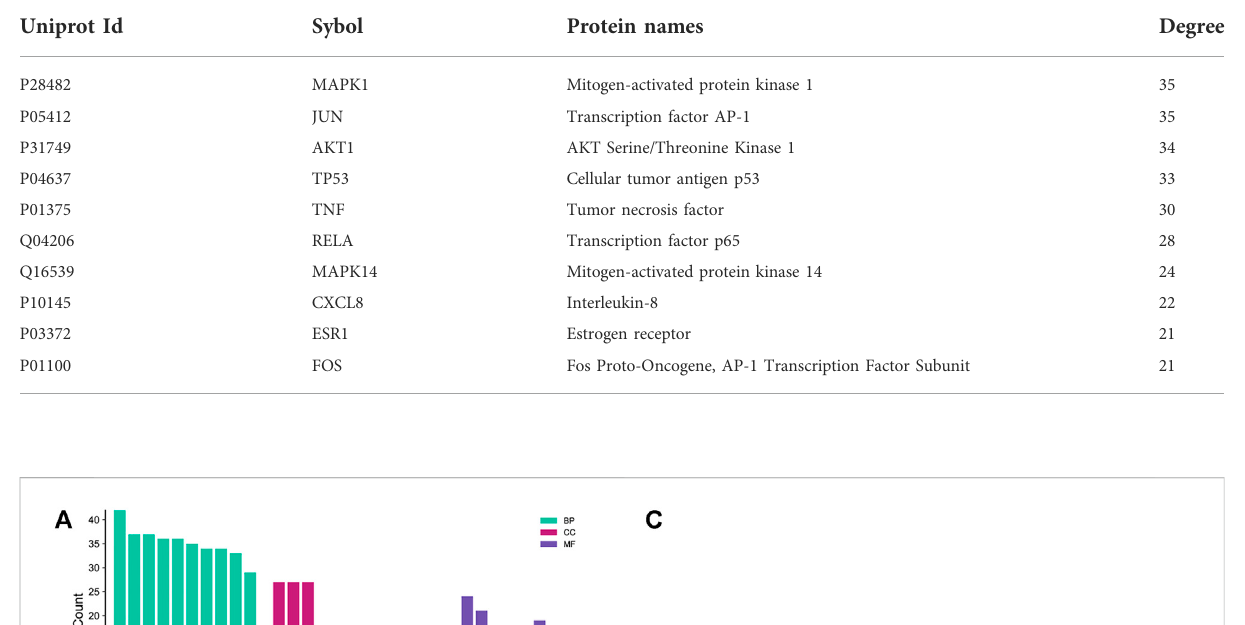
TABLE 2 Top 10 core proteins information.